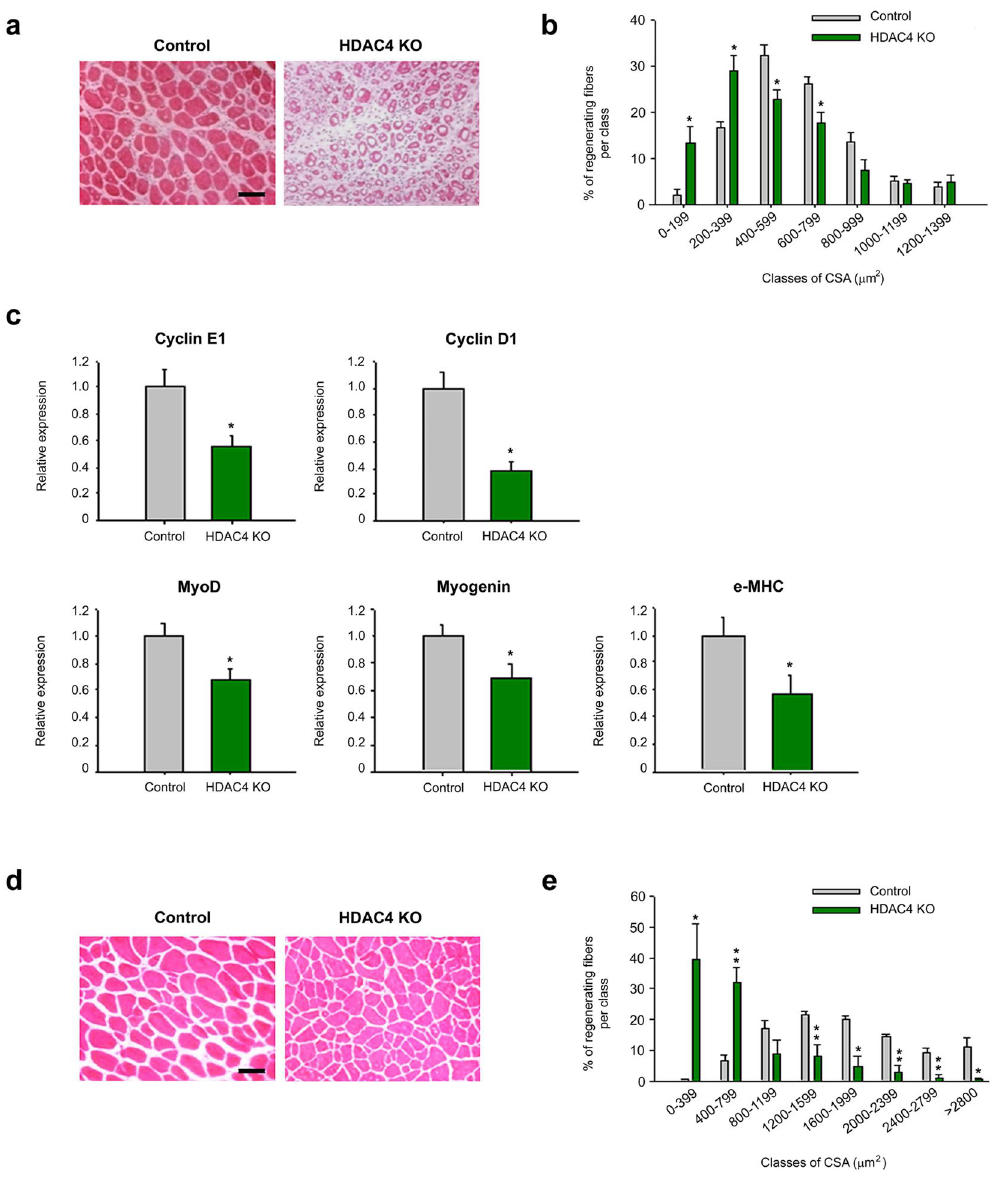
Figure 4. HDAC4 is essential for skeletal muscle regeneration. ( a ) Representative images of tibialis anterior regenerating muscles, one week after injury. Scale bar: 50 μ m. ( b ) Morphometric analysis of the distribution of regenerating fiber cross-sectional area, one week after injury. n = 5. Data are presented as average + / − SEM. * p < 0.05 by Student’s t test. ( c ) Real-time PCR for proliferative and myogenic markers in HDAC4 KO and control mice, 2.5 days following injury. n = 7. Data are presented as average + / − SEM. * p < 0.05 (Student’s t-test). ( d ) Representative images of TA regenerating muscles, one month after injury. Scale bar: 50 μ m. ( e ) Morphometric analysis of the distribution of regenerating fiber cross-sectional area, one month after injury. n = 5. Data are presented as average + / − SEM. * p < 0.05; ** p < 0.005 (Student’s